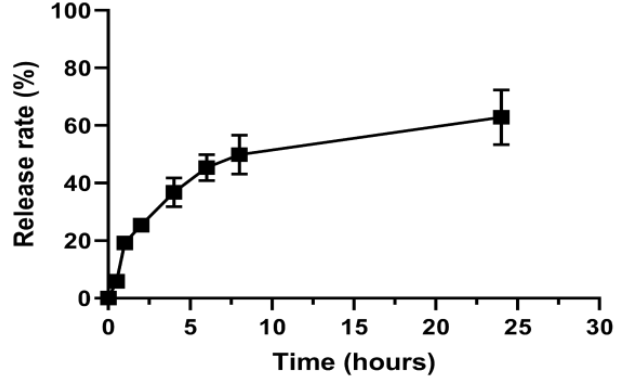
Figure 1. Cumulative percentage of quercetin released from NLC-QU.